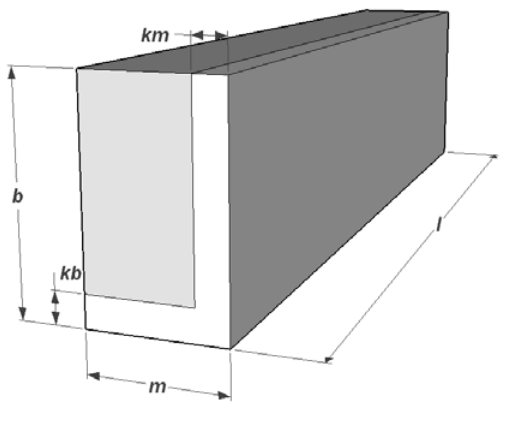
Figure 11. Loss of timber volume by drying.